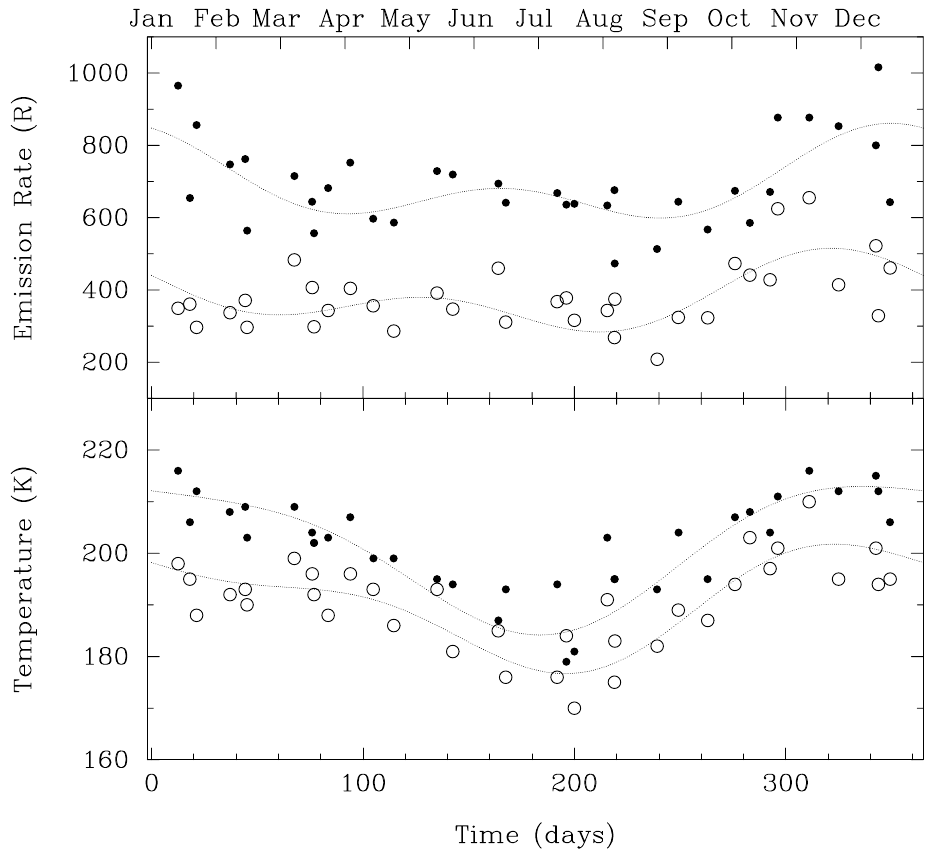
Fig. 4. Average rotational temperatures and emission rates. Open circle: from O 2 . Full circle: from OH. Dotted Line: numerical reproduc-